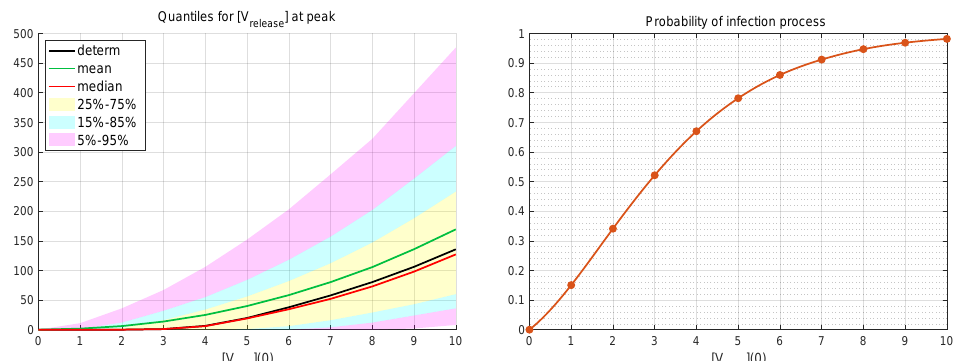
Figure 6. ( Left ) Dependence of confidence intervals, sample mean (green) and median (red) estimates, and the deterministic solution (black) on the initial number of free virions per cell [ V free ]( 0 ) at t = 24 h. ( Right ) Probability for productive infection of the target cell in relation to the initial number of free virions per cell